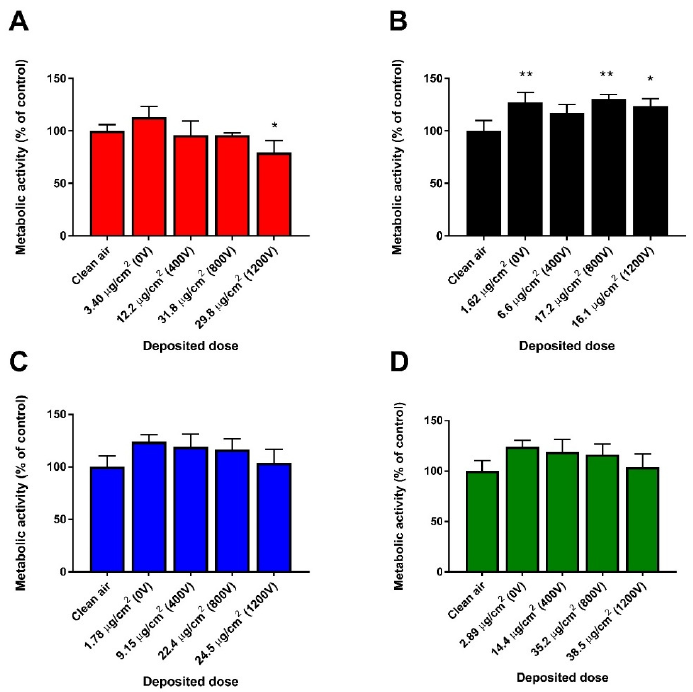
Figure 3. Effect on metabolic activity of HBE cells after 4 h exposure to TiO 2 agglomerates at